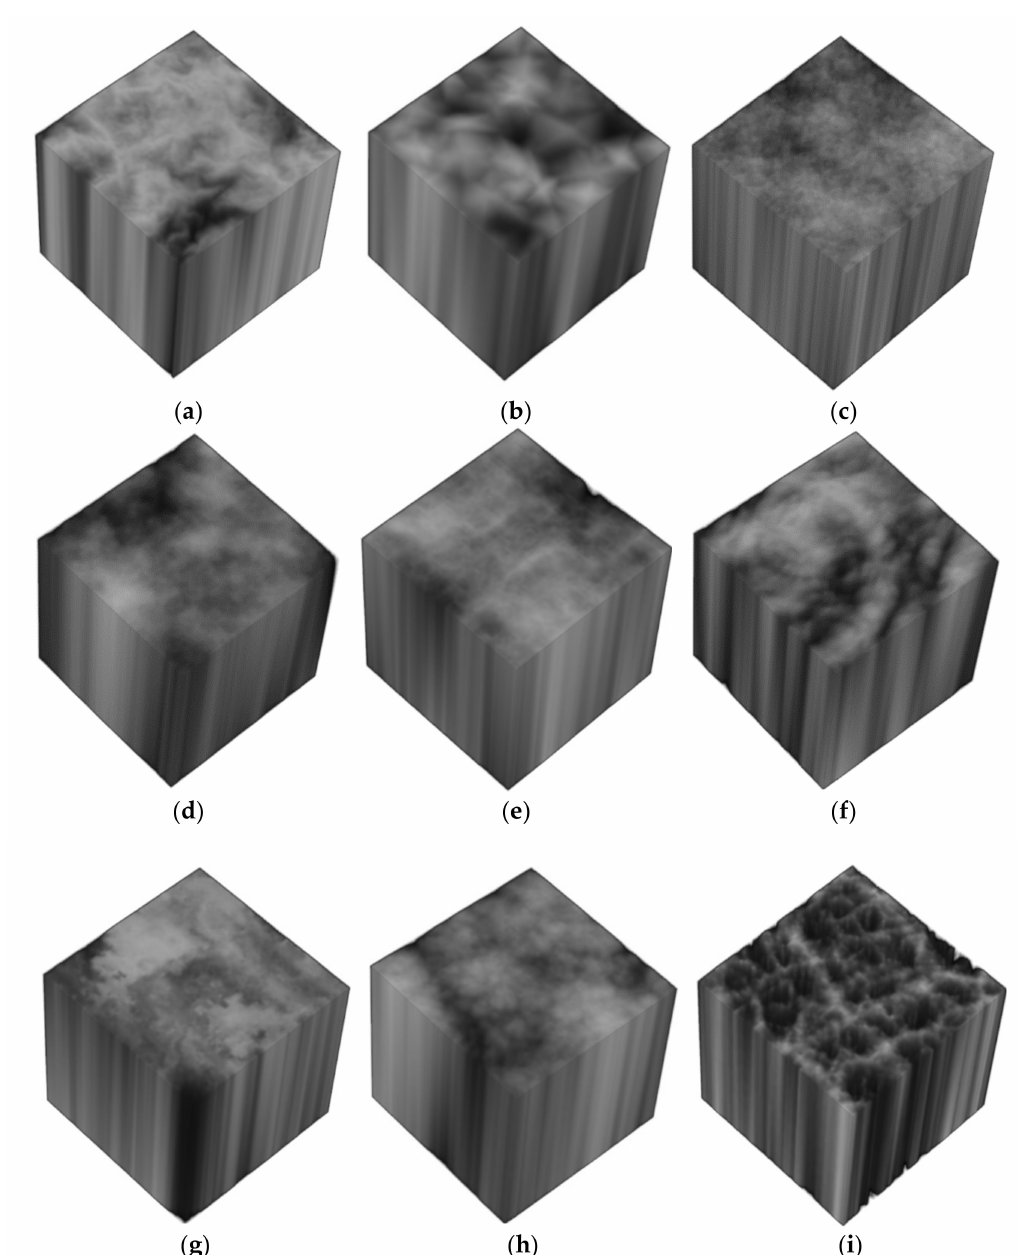
Figure 10. Examples of normal texture images from each considered category: ( a ) Blobs ( b ) Blocks ( c ) PerlinAmp ( d ) PerlinNoise ( e ) RidgedPerlin ( f ) SinusSynthesis ( g ) Stone ( h ) Uwari ( i )